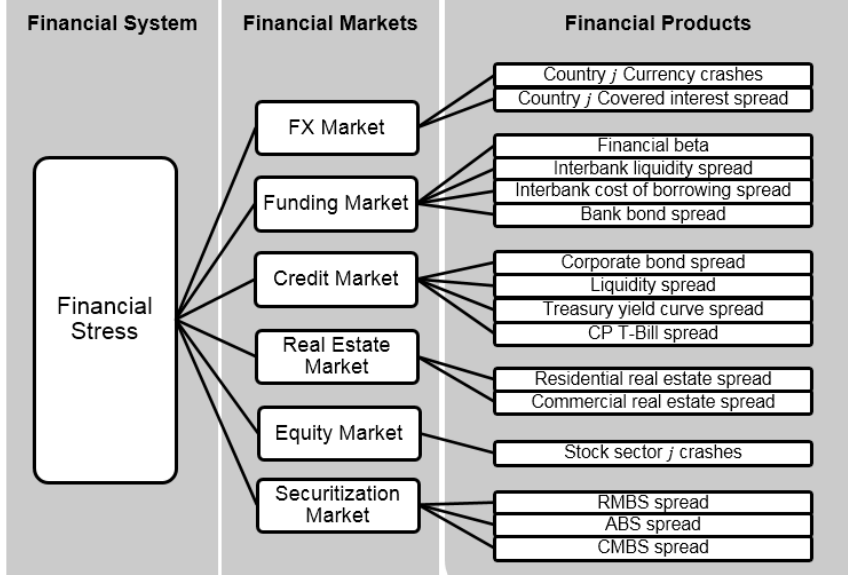
Figure 1. Conceptual model of financial system